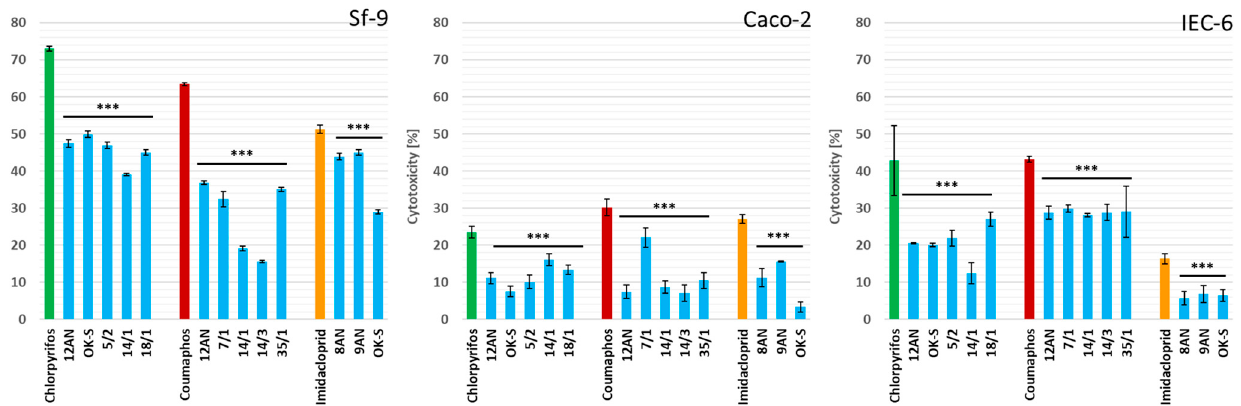
Figure 2. Decrease in cytotoxicity of chlorpyrifos, coumaphos, and imidacloprid after 24 h incubation with lactic acid bacteria (LAB) strains measured by MTT (3 ‐ (4,5 ‐ dimethylthiazol ‐ 2 ‐ yl) ‐ 2,5 ‐ diphenyltetrazolium bromide) assay. Each data point represents the mean of the absorbance values from cells from eight individual wells. Results are presented as mean ± standard deviation (SD). Statistical significance was calculated versus positive control (appropriate pesticide standard), * p ≤ 0.1, ** p ≤ 0.05, *** p ≤ 0.01.